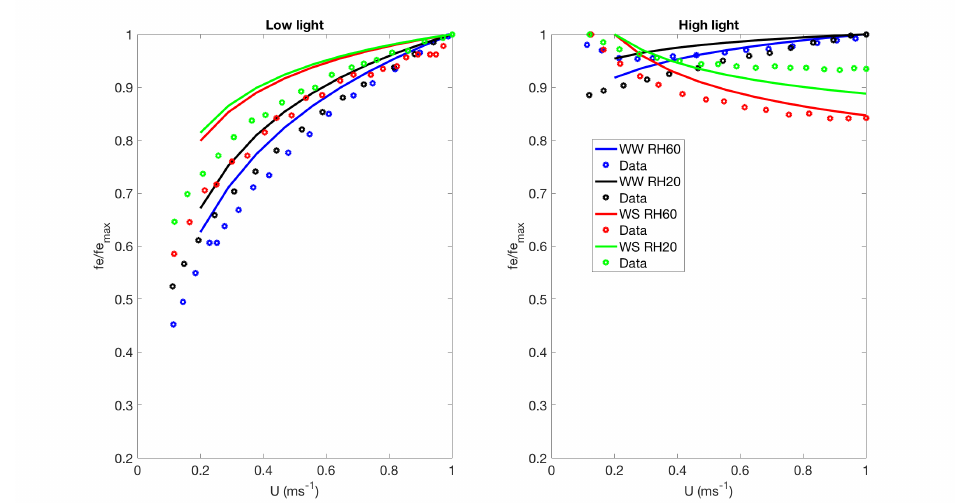
Figure 3. Comparison of the model with digitized data outputs from Huang et al. [18]. x axis shows wind speed and y axis shows normalized transpiration. Different colors indicate different water-supply demand conditions as discussed in Section